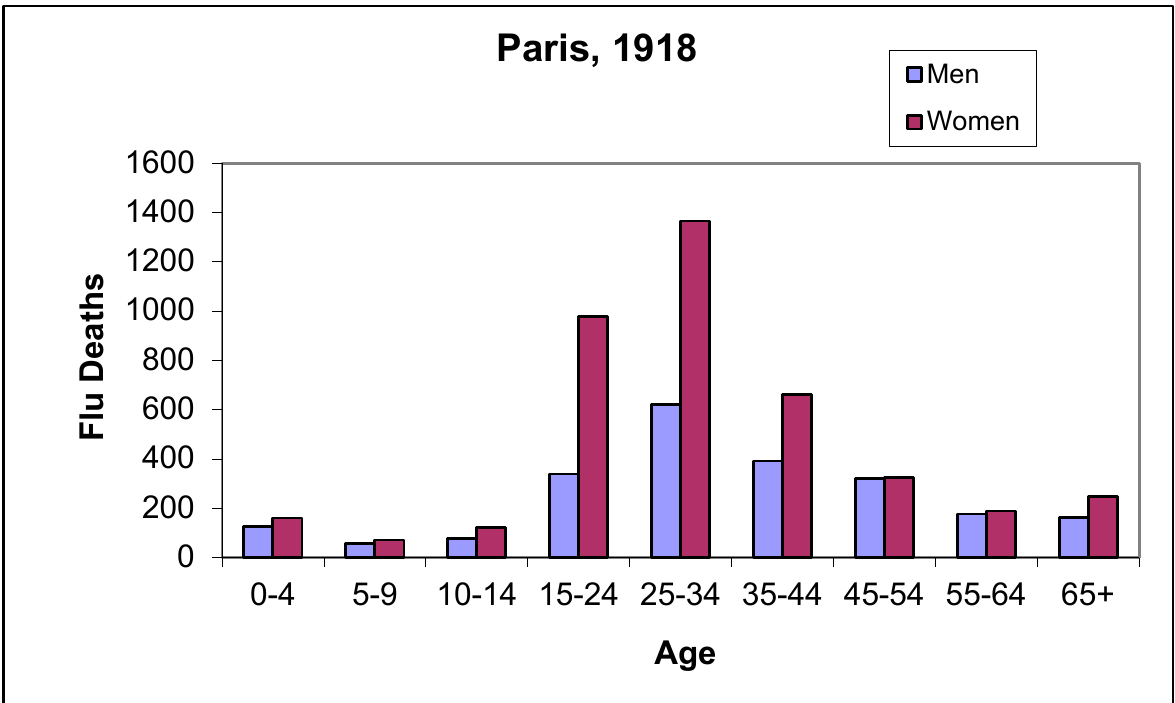
Figure 4. Ages of those dying of influenza (A/H1N1 virus) in Paris in 1918. Source: “Annuaire statistique de la ville de Paris” [15].